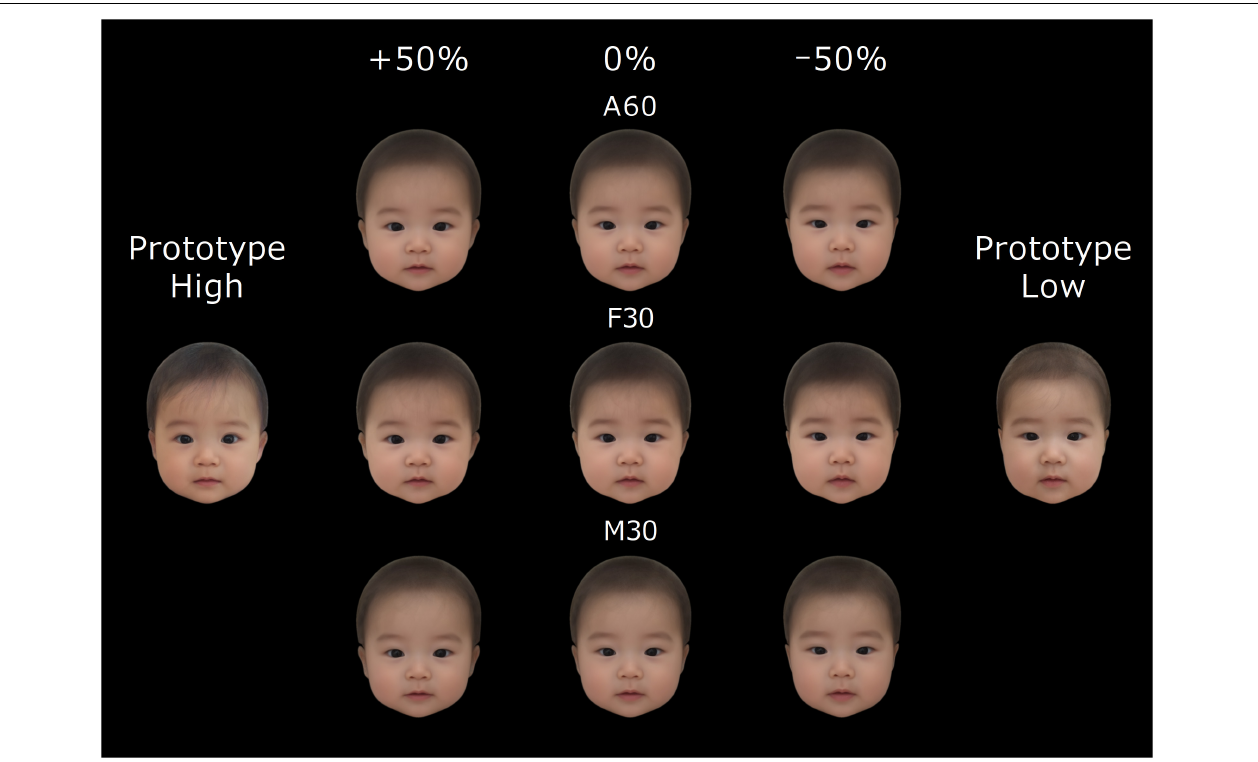
FIGURE 1 | Average faces (0%), manipulated faces ( + 50%: cuter, –50%: less cute), and prototypical high- and low-cuteness faces. A60: Average face of 30 female and 30 male babies. F30: Average face of 30 female babies. M30: Average face of 30 male babies. The facial images are computer generated.